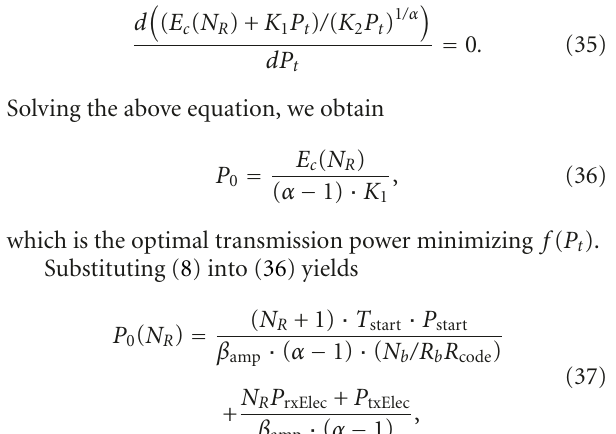
algorithm o ff ers a method to achieve N R opt under a delay